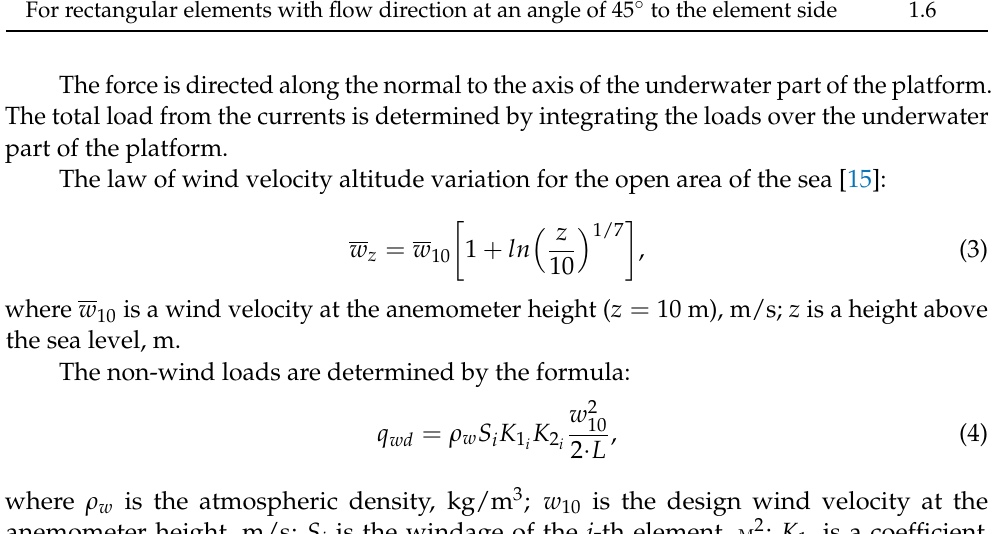
Table 5. The form drag coefficient for the loads’ calculation from currents [15]. Windage Element C D For cylindrical elements 1.05 For rectangular elements with flow direction, which is parallel to the element side 2.0 1.6